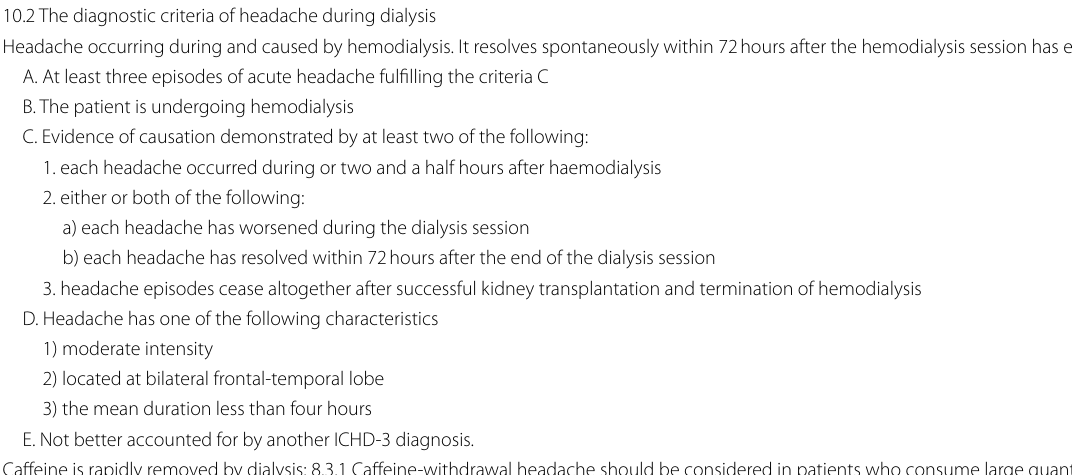
Table 5 Recommended diagnostic criteria for dialysis-related